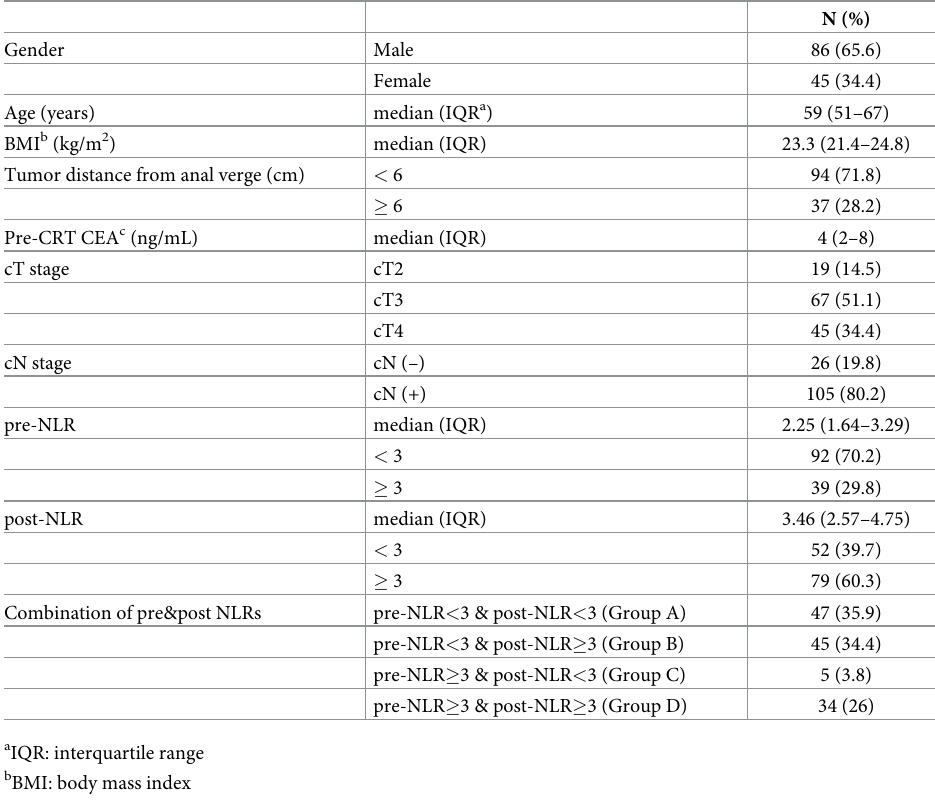
Table 1. Clinicopathologic characteristics of overall patients (n =